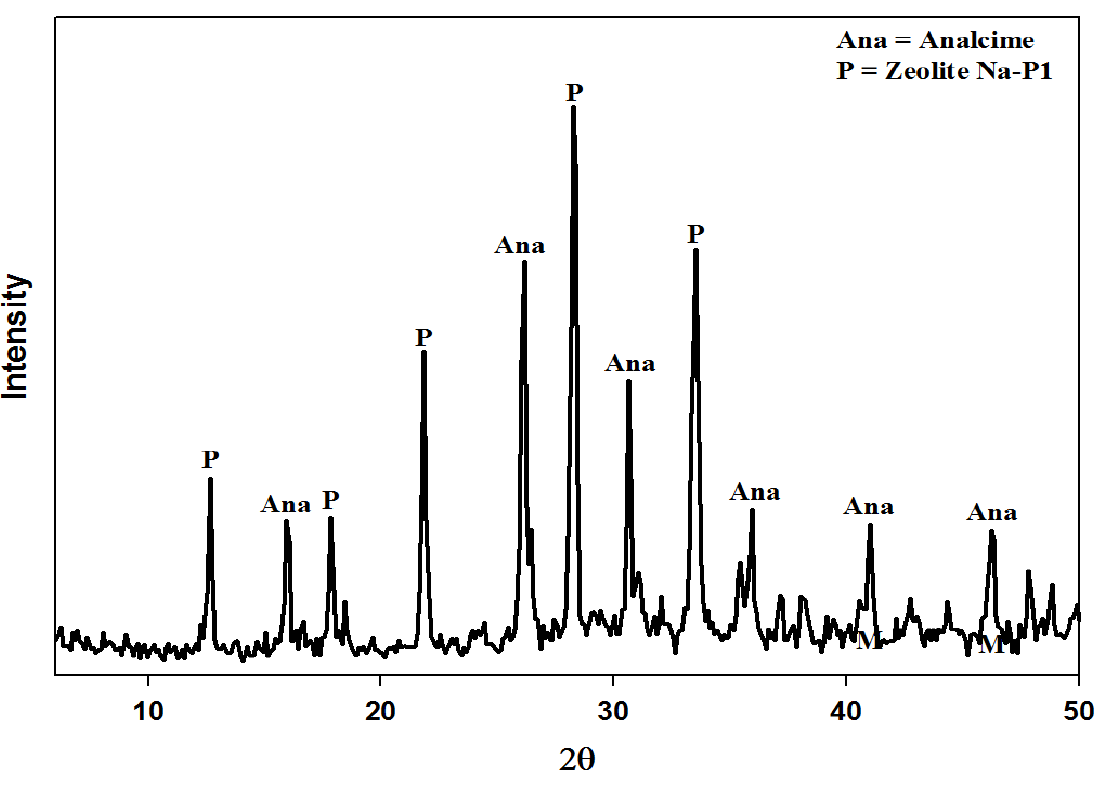
Figure 1. X-Ray powder diffraction (XRD) patterns illustrating the two zeolite crystal products produced by applying the 2-step method as synthesis